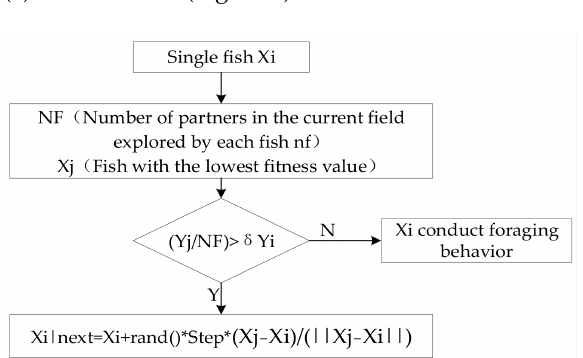
Figure 4. AF-Follow.